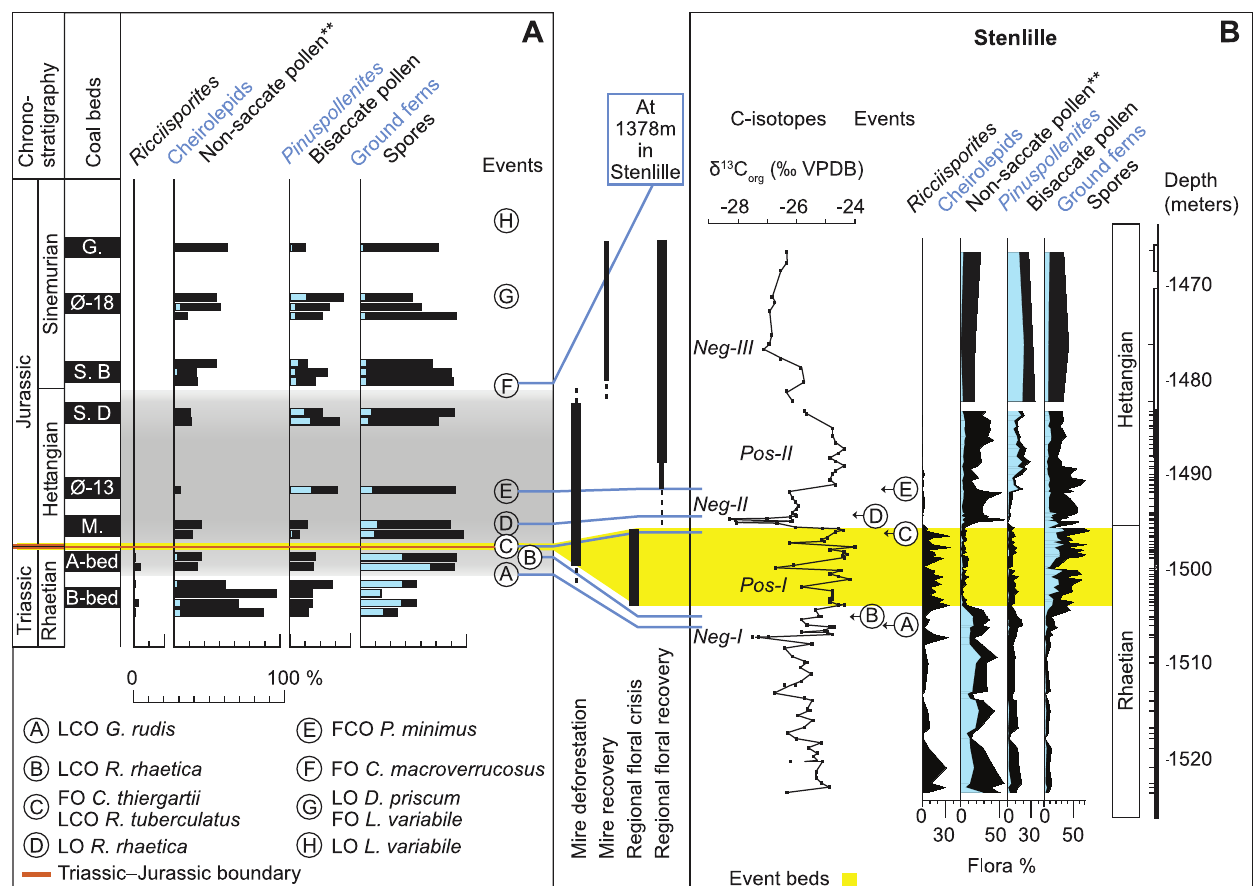
Figure 7. Correlation of the regional palynological signal. Correlation of A the overall palynological record from the coal/coaly beds of the Danish Basin with that of B the Stenlille record [26], showing onset of mire deforestation probably commenced prior to regional deforestation (yellow field), and delayed mire ecosystem recovery compared to the overall regional vegetation.